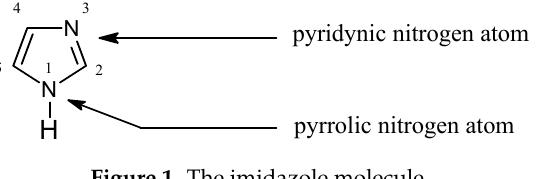
Figure 1. The imidazole molecule.